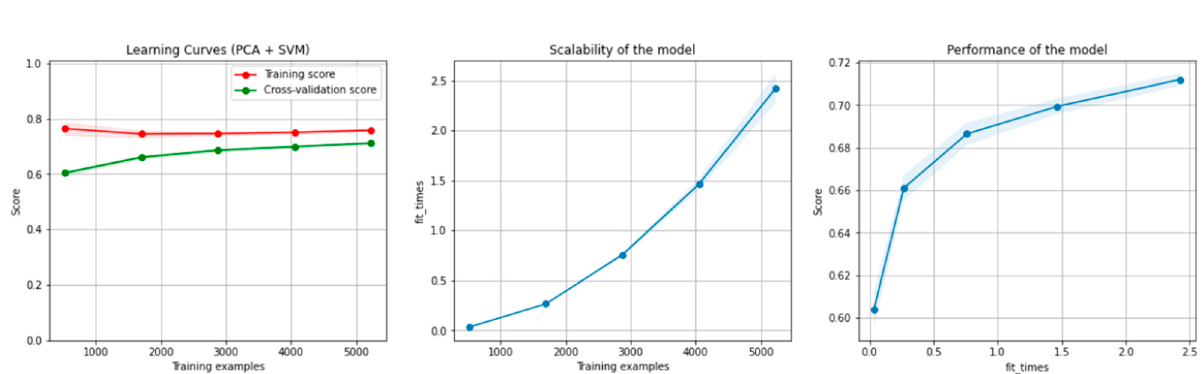
Figure 12. Learning curves, model scalability and model performance for the SVM algorithm, for the overlapping dataset.